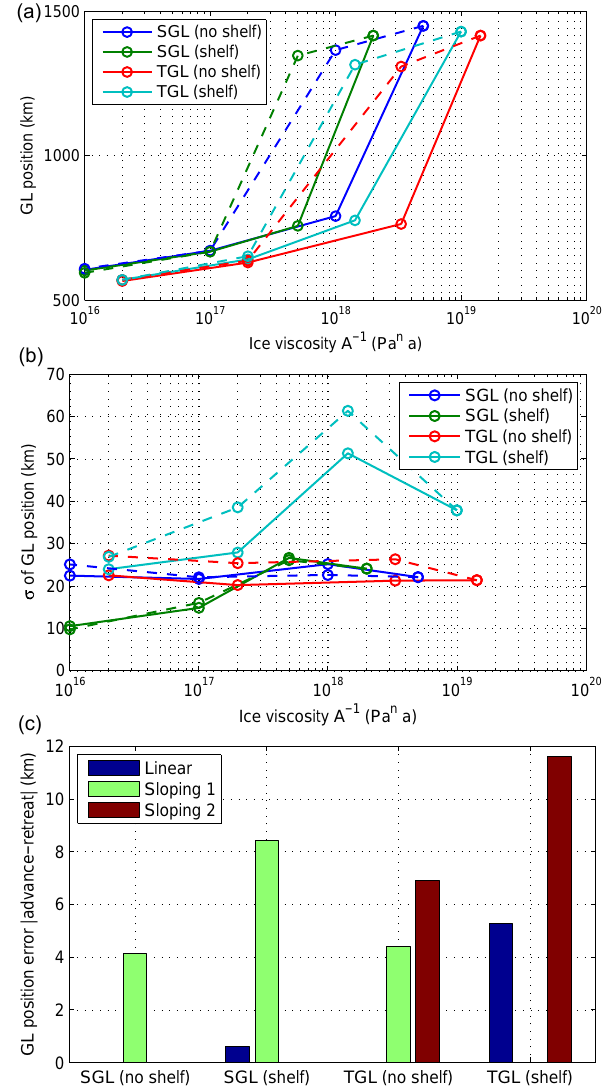
Figure C2. Median (upper panel) and standard deviation (centre panel) of steady-state grounding-line positions according to the MISMIP experiments for a circular ice sheet as a function of the flow parameter A (Pa − n a − 1 ) for the overdeepened bedrock experi- ment according to different flux conditions at the grounding line and inclusion or exclusion of ice shelves. Solid lines represent advance and dashed lines represent retreat experiments. The lower panel displays the difference in grounding-line position for the steady- state ice sheets obtained during advance with those obtained during retreat (same parameter values) for the linear-sloping bed (linear) and the overdeepened bed. The latter has two sections with stable steady-state solutions: a small ice sheet (sloping 1) and a large one (sloping